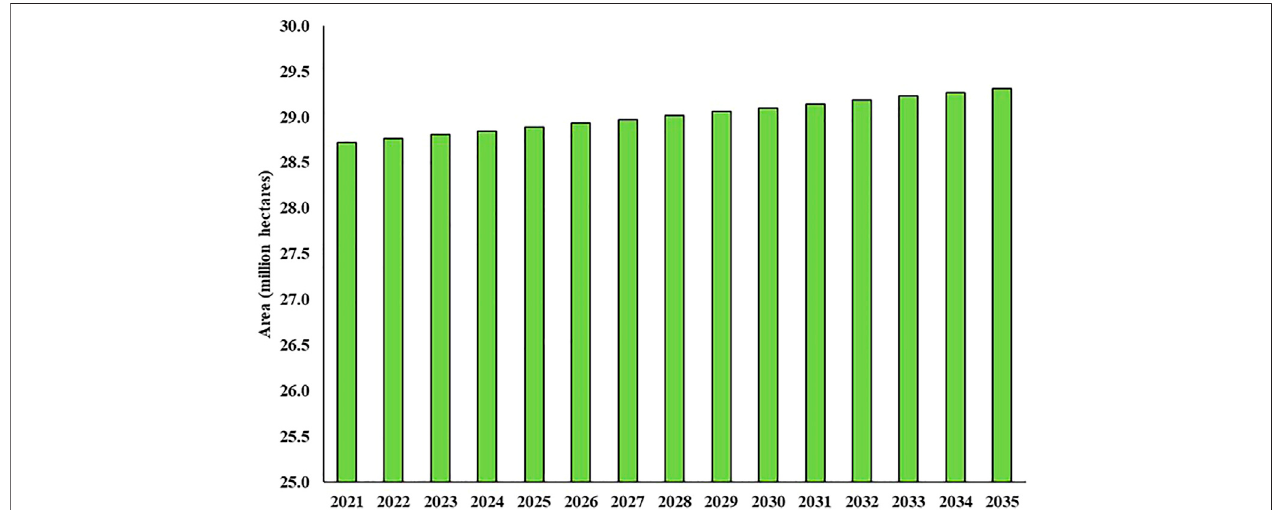
FIGURE 3 | Potential area for oilseed cover crops from 2021 to 2035 in the United States.